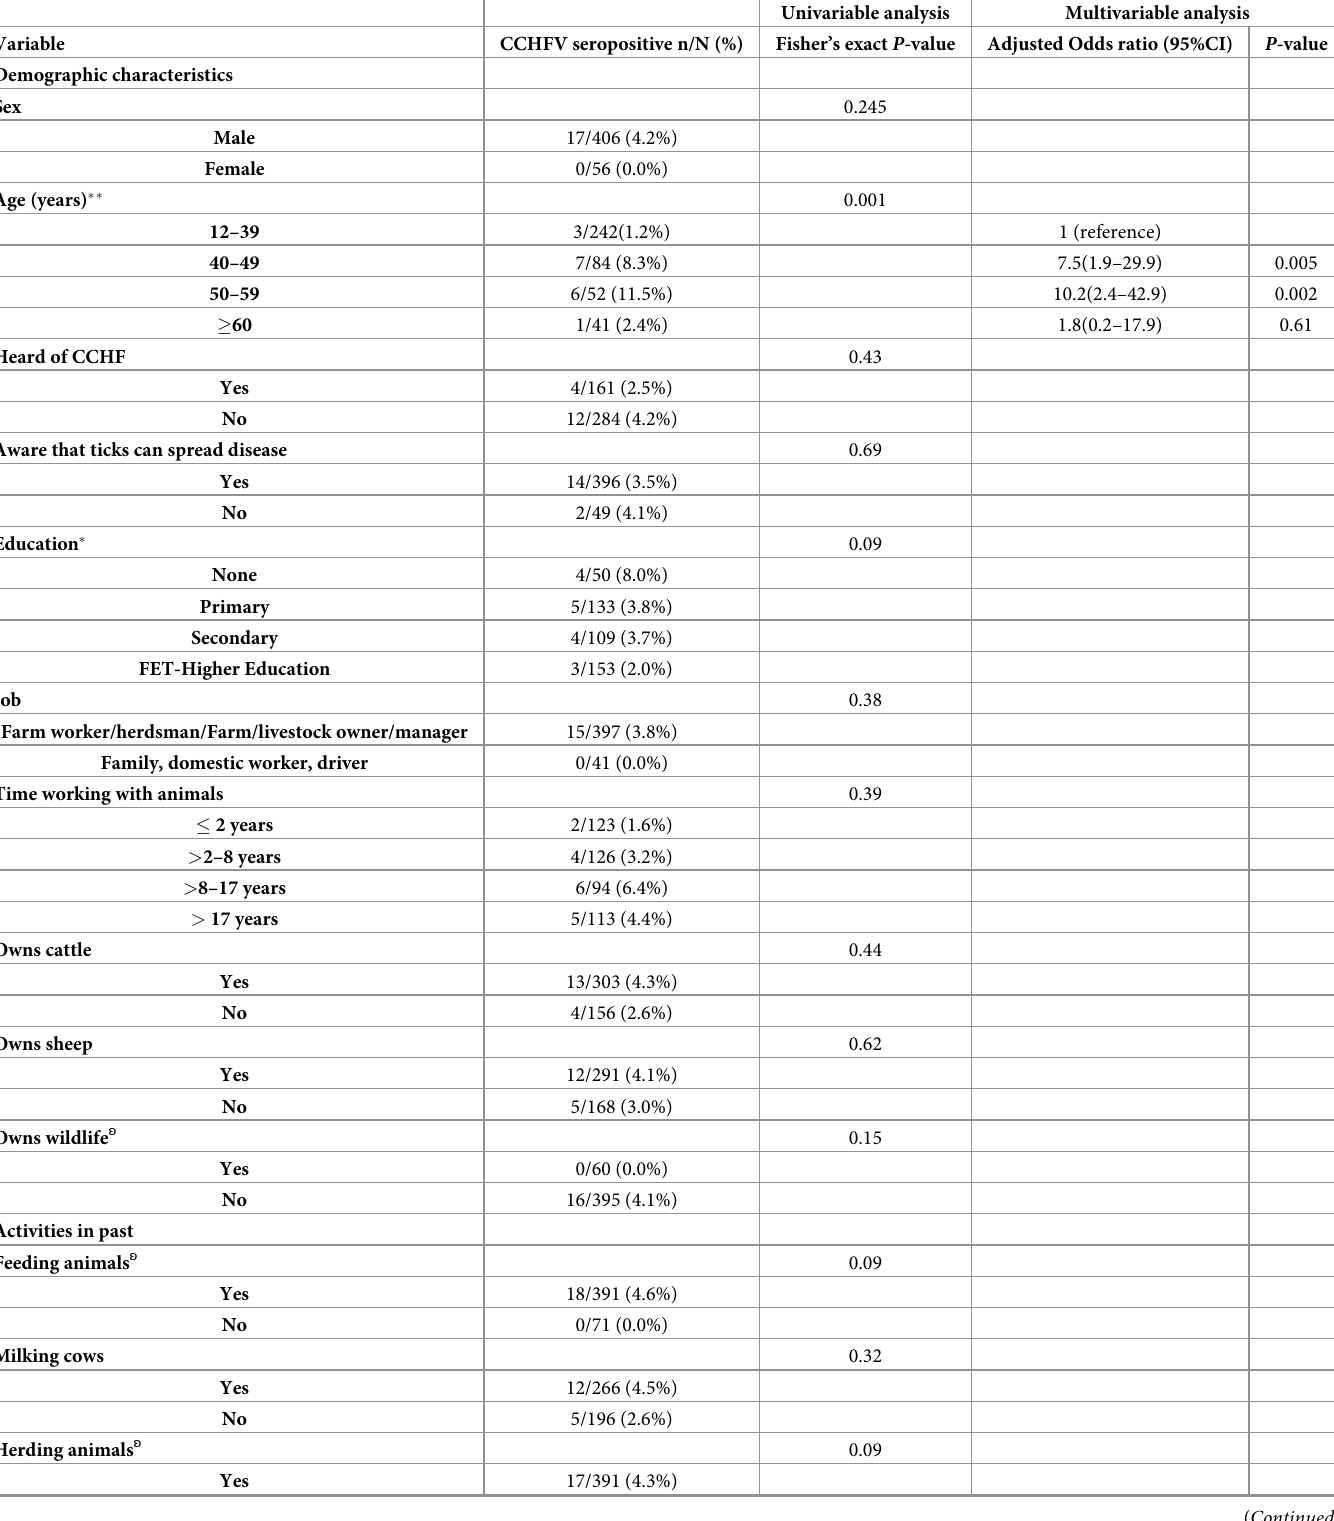
Table 3. Factors associated with Crimean-Congo haemorrhagic fever virus exposure in farmers and farm workers in central South Africa, 2017 (S2